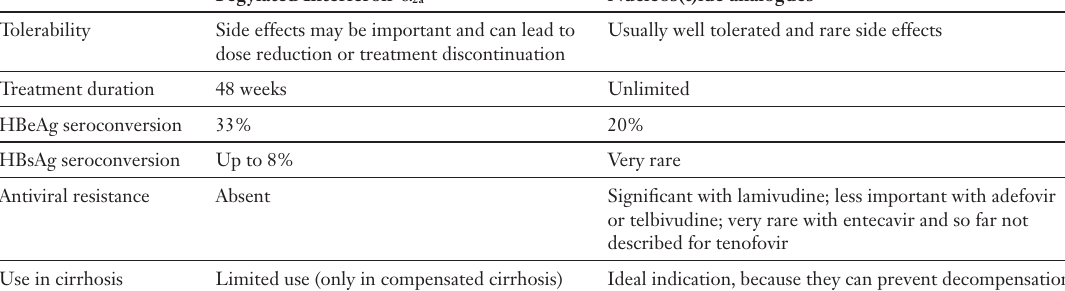
Table 8 Advantages and disadvantages of PEG-IFN- a 2a and NUCs for the treatment of chronic hepatitis